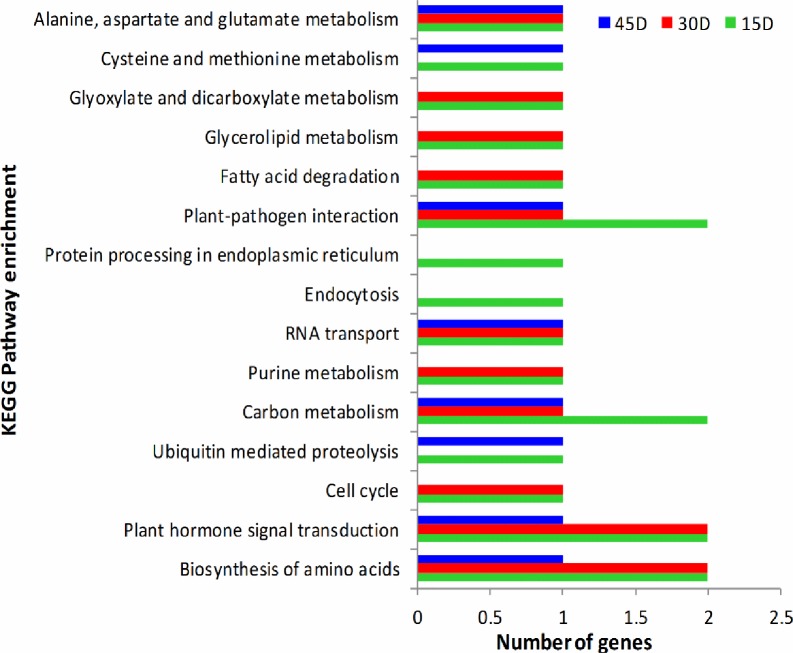
Prime pathway of KEGG enrichment analysis.15D, 30D and 45D indicated differentially expressed genes at days 15, 30 and 45 sugarcane roots in the response of strain MYSP.